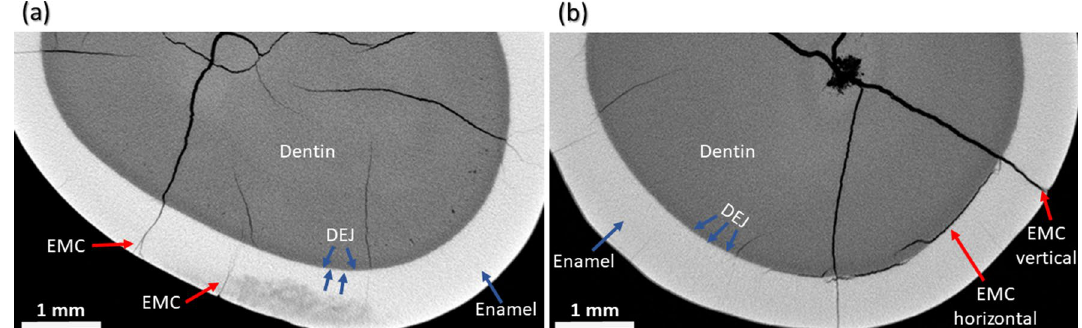
Figure 8. The position of an EMC with respect to the DEJ when the EMC is ( a ) invisible and ( b ) visible on the outer buccal surface. Anatomical tooth structures (dentin, DEJ, enamel, EMC) are